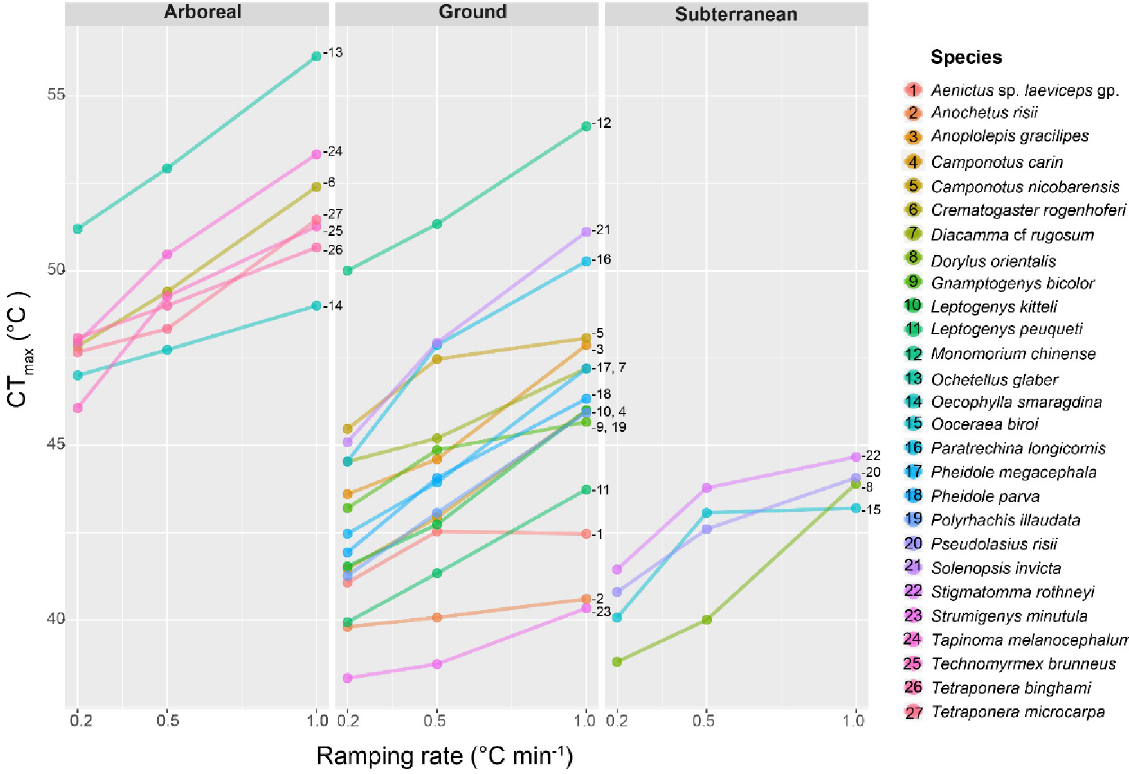
Fig 2. Results of dynamic assays. Line plots of CT max values measured in function of three ramping rates used for 27 ant species found in function of their vertical stratification (arboreal, ground and subterranean strata).